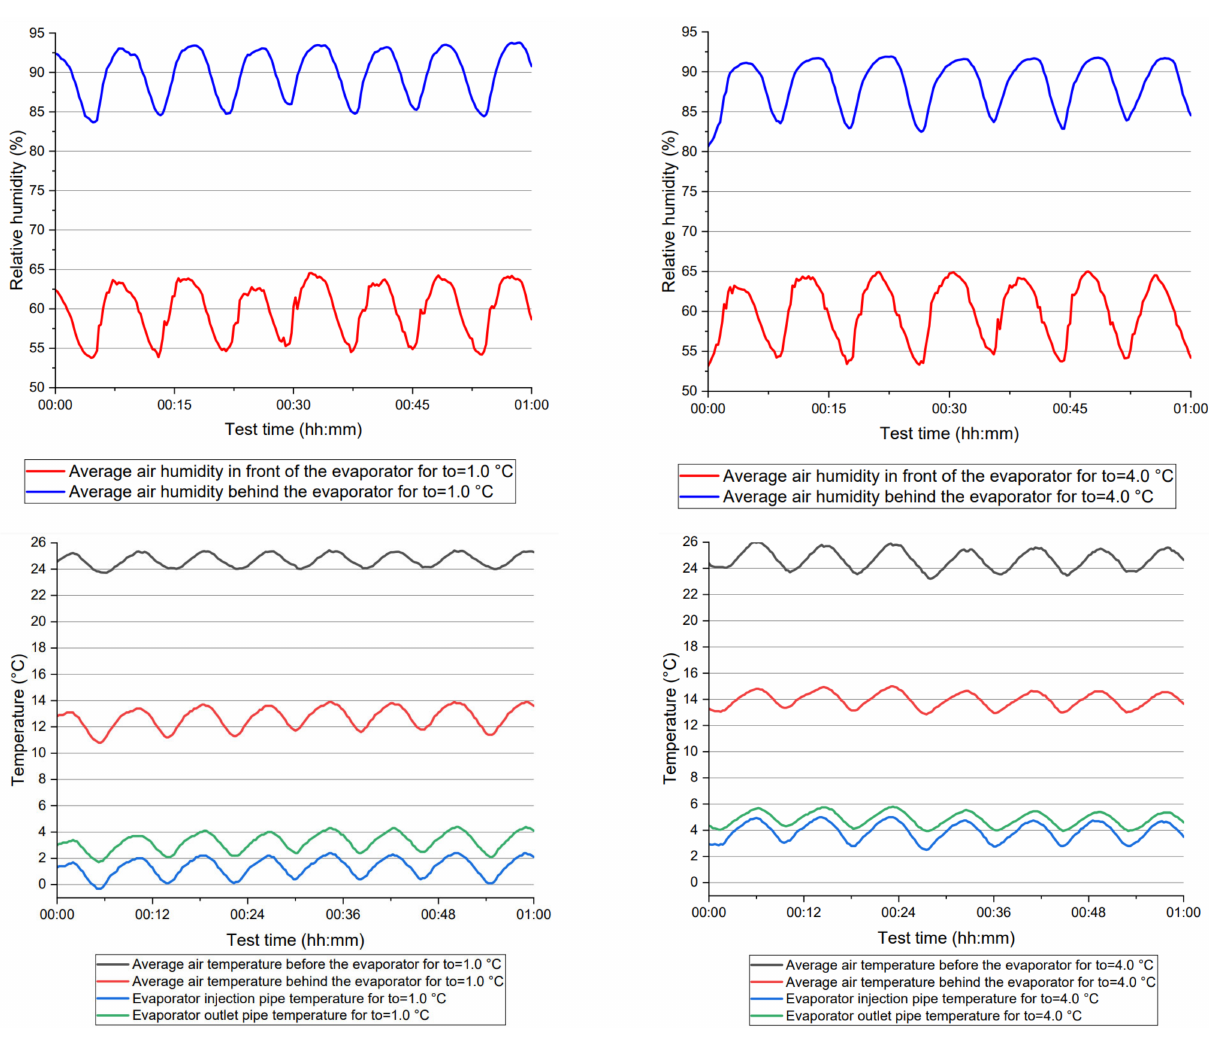
Figure 4. Graphs of temperature and air humidity for two heat pump operating